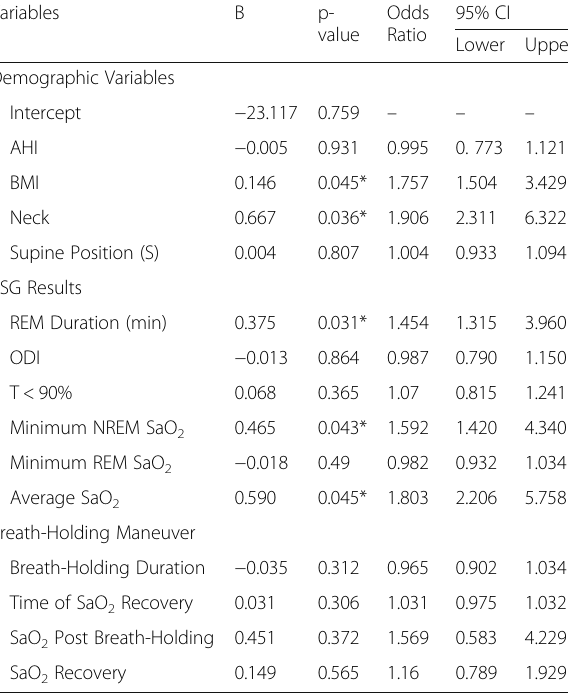
Table 1 Demographic, anthropometric, polysomnographic and titration data in CPAP and BiPAP groups